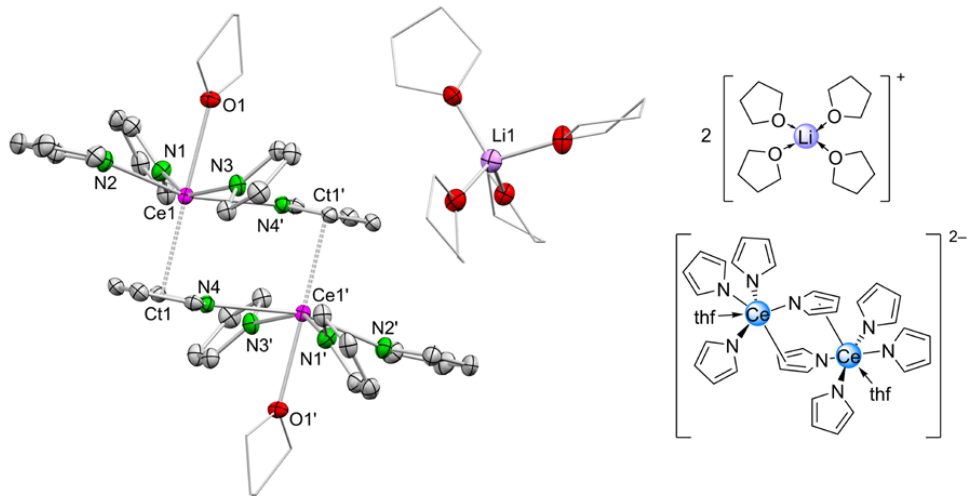
Figure 3. Crystal structure of [Ce 2 (pyr) 6 ( µ -pyr) 2 (thf) 2 ][Li(thf) 4 ] 2 ( 4 ). Ellipsoids are shown at the 50% probability level. Hydrogen atoms and the second [Li(thf) 4 ] + counter ion are omitted for clarity. Selected interatomic distances (Å) and angles ( ◦ ): Ce1 − N1 2.512(2), Ce1 − N2 2.475(2), Ce1 − N3 2.515(2), Ce1 − N4 (cid:48) 2.622(2), Ce1 − Ct1 2.575(16), Ce1 − O1 2.5138(17); N1 − Ce1 − N2 97.21(7), N1 − Ce1- N3 153.53(8), N1 − Ce1 − N4 86.15(7), N1 − Ce1 − O1 78.80(7), and N4 − Ce1 (cid:48) − Ct1 (cid:48)